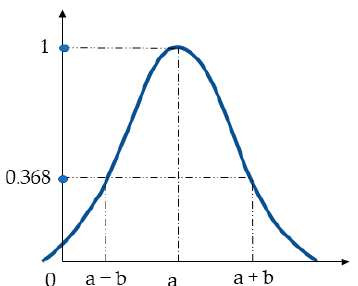
Figure 2. The shape of the membership function of a Gaussian fuzzy number.